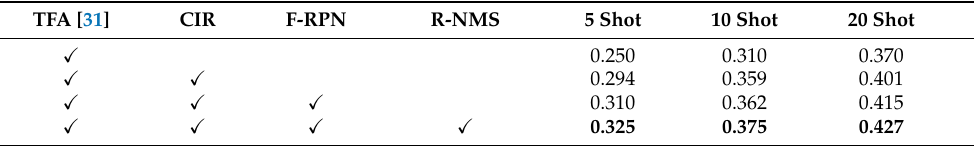
Table 5. Ablation experiment on the DIOR Dataset.